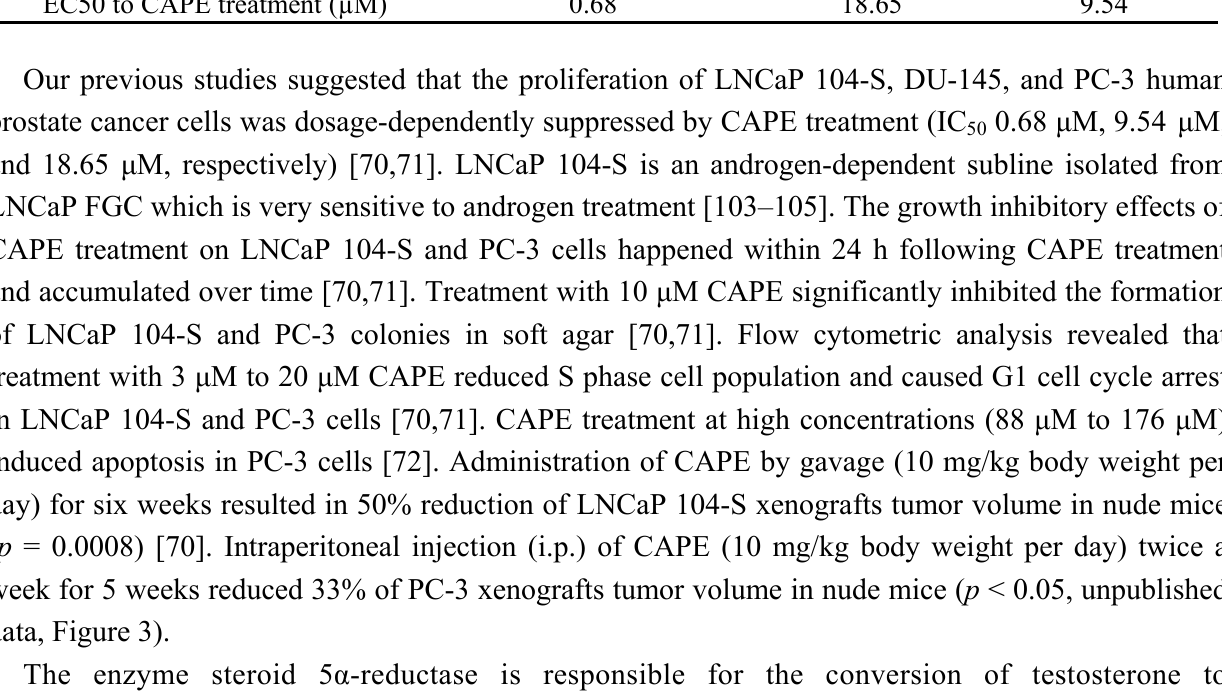
Table 1. Characteristics of commonly used human prostate cancer cell lines. Characteristics, including androgen receptor (AR) level, p53 and phosphatase and tensin homolog (PTEN) status, androgen-dependency, and capability to generate prostate-specific antigen (PSA), of LNCaP 104-S, PC-3, and DU-145 cells are listed. LNCaP 104-S PC-3 DU-145 AR + − − p53 + − mutant PTEN − − + androgen-dependency dependent independent independent androgen effect on cell proliferation stimulation no response no response differentiation well poorly poorly originality lymph-node metastases bone-metastases brain-metastases PSA production + − − EC50 to CAPE treatment (µM)